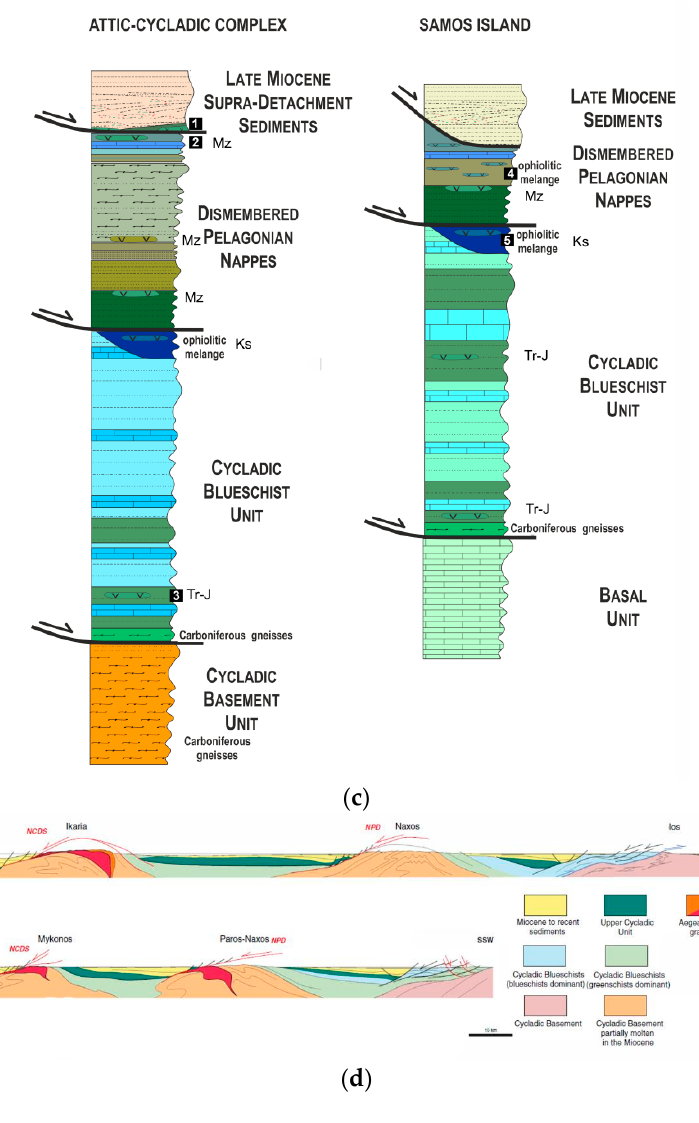
Figure 1. ( a ) Distribution of Mesozoic ophiolite complexes in the Hellenides and its northward and eastward continuation in the Dinarides and the Taurides, respectively. The tectonic sketch map is modified after [7,8]. Abbreviations: Alb = Albanian, BR = Brezovica, G = Guevgueli, Mir = Mirdita (Albania), O = Othris, Pi = Pindos, S = Sithonia, V = Vourinos. ( b ) Simplified geological map of the Attic-Cycladic Crystalline Belt, showing the major tectonic units. Distribution of the Cycladic Blueschist Unit (CBU), the Cycladic Basement rocks, and the Pelagonian unit within the ACC is also shown (modified after [12] and references therein). ( c ) Schematic tectono-stratigraphic sequence of the main Cycladic units after [1,12–14] and Samos nappe piles after [19,26]. The stratigraphic location of the ophiolitic rocks is marked with numbers on the columns: 1—Naxos and Paros dismembered supra-detachment ophiolites; 2—Skyros melange; 3—Naxos amphibolites from the CBU; 4—western Samos (Kallithea) mélange; 5—central Samos meta-ophiolitic mélange (CBU). Age abbreviations: Mz—Mesozoic, Ks—Cretaceous; Tr-J—Triassic-Jurassic. ( d ) Structural cross-sections across the Cycladic metamorphic belt showing the main structural units and the location of ophiolitic rocks, modified after [9].